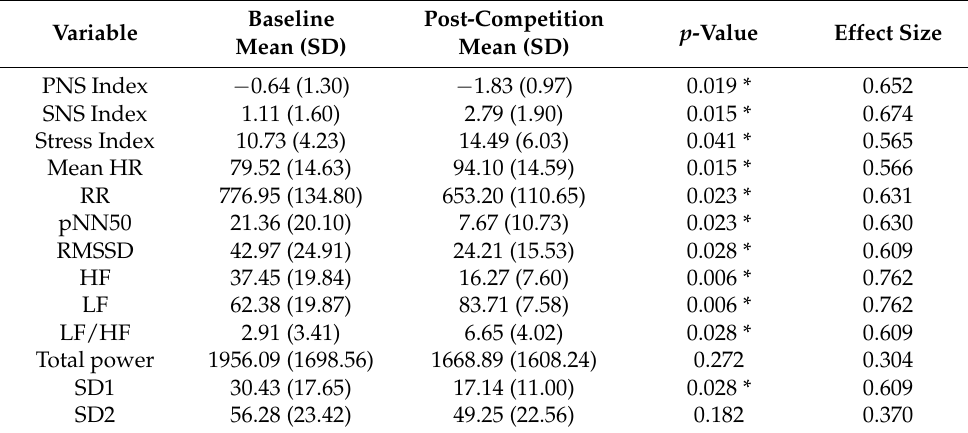
Table 3. HRV at baseline and after winning a soccer match for female soccer athletes.